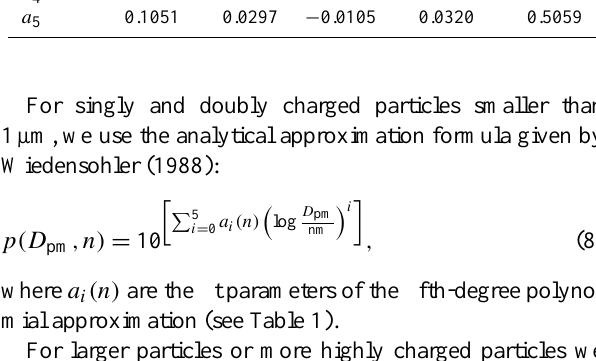
Fig. 1. Schematic of a triangular DMA transfer function Fig. 31: Schematic of a triangular DMA transfer function Table 31: fit parameter for specific charge of the fifth degree polynomial approximation of Wiedensohler (1988)